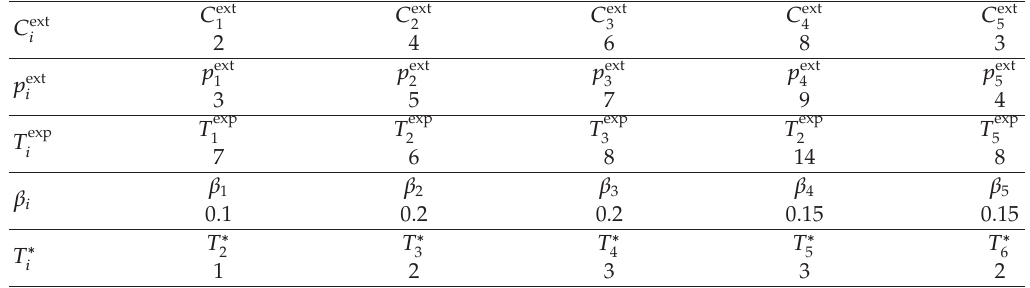
Table 3: Basic data (cid:2) 3.2 (cid:3)